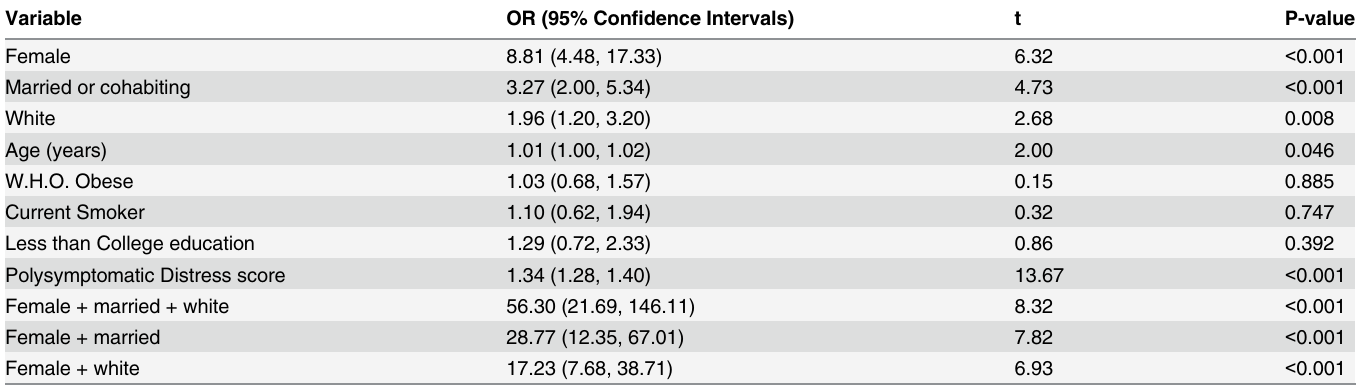
Table 5. Multivariable logistic regression of predictors of physician diagnosis of fibromyalgia: Model predicting persons told by a physician that they that fibromyalgia (including Polysymptomatic Distress Score).